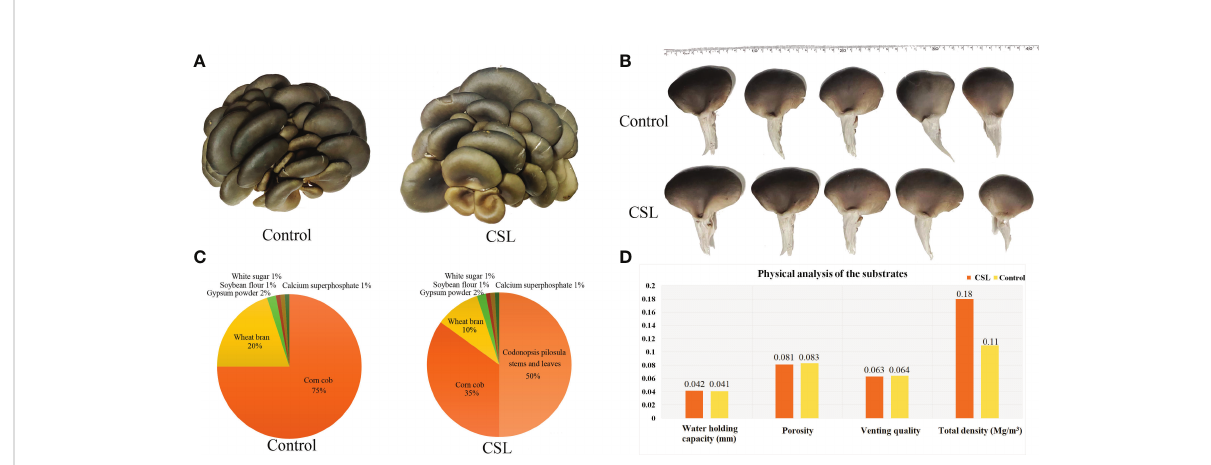
FIGURE 1 The fruiting body of P. ostreatus and physical parameter of the substrates. samples (A) , pileus diameter (B) , the formula of cultivation substrate (C) , physical analyses of substrates (D)